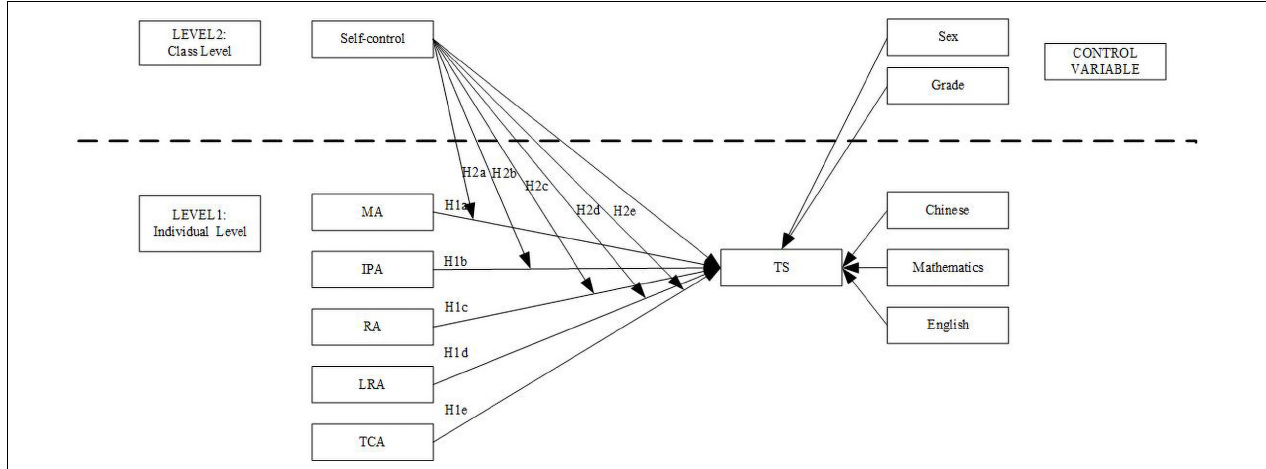
FIGURE 1 | Hypothesized model. MA, Memory ability; IPA, Information processing ability, RA, Representation ability; LRA, Logical reasoning ability, TCA, Thinking conversion ability. TS–Comprehensive Academic